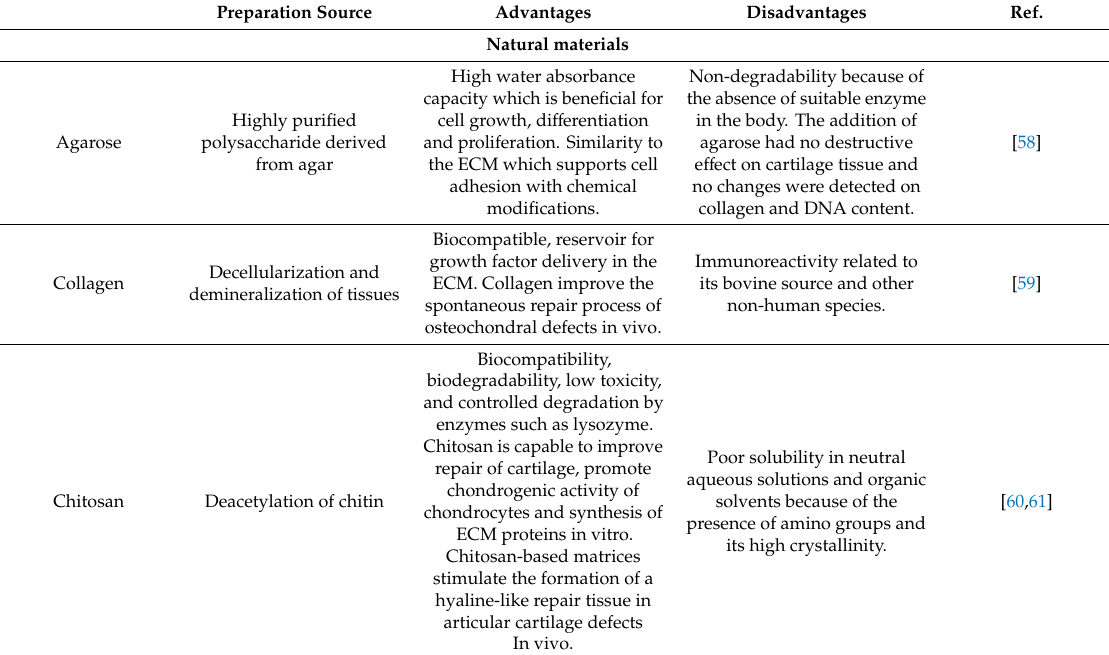
List of selected biomaterials in cartilage regeneration including their advantages and